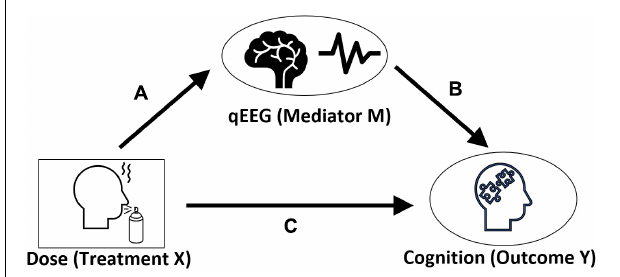
FIGURE 1 | A mediation model. Effect of dosage on Cognition via qEEG. All three are repeated measures at two-time points. Ovals are latent variables, whereas rectangle shows observed variables. In this causal diagram, path c is the “direct effect of the Dose on Cognition.” Path following links a and b represent the “mediation effect” we wish to test.